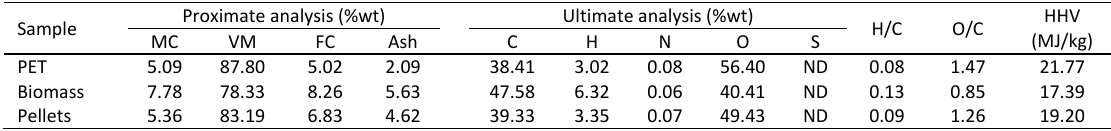
Table 1: Properties of the raw materials and PET/biomass pellets